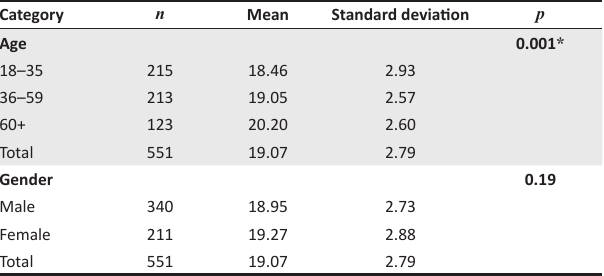
TABLE 6: Disability scores for physical impact of lower limb fractures ( n = 551).